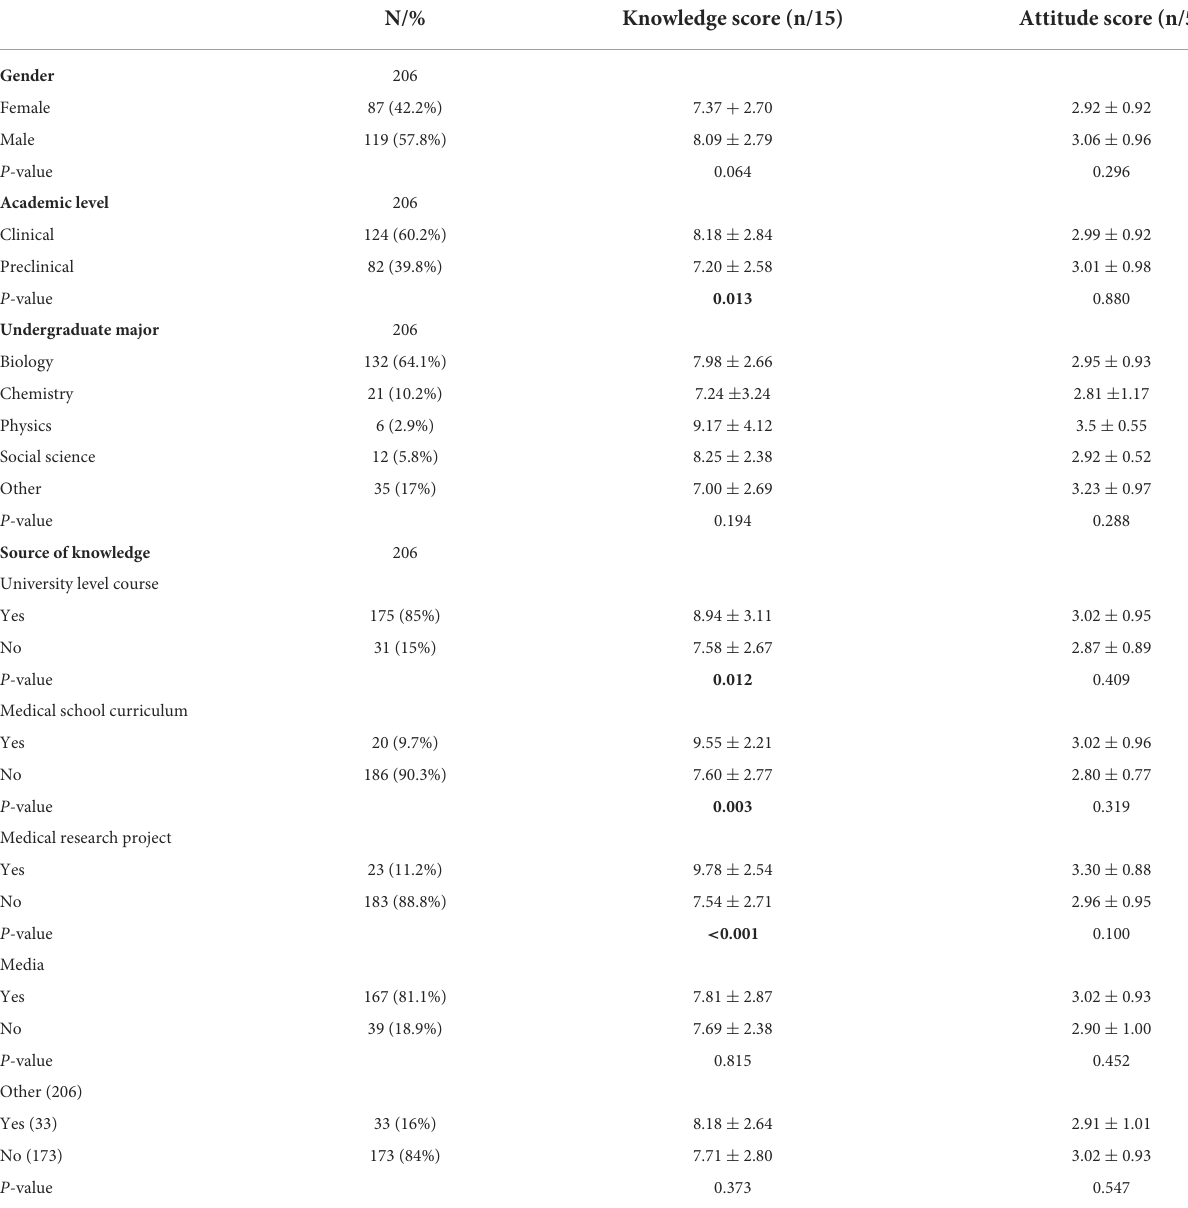
TABLE 1 Demographic characteristics of the participants and differences in knowledge and attitude